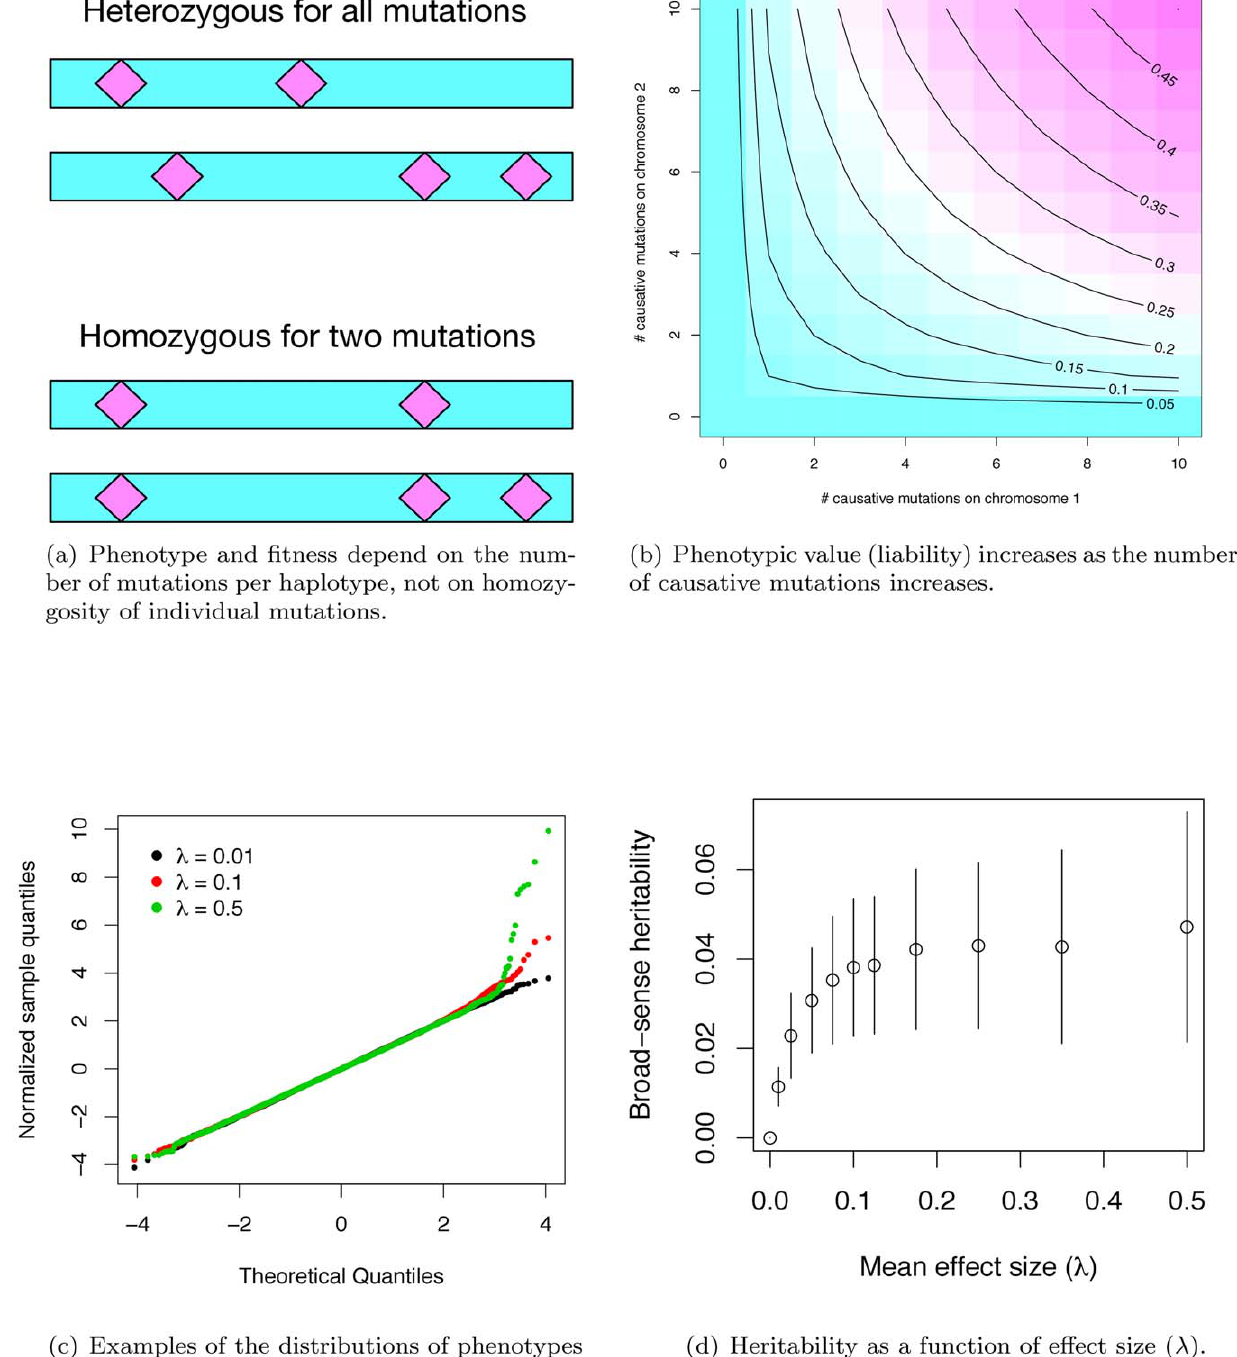
Figure 1. Phenotypes under the gene-based model. (a) Phenotype depends only on the number of causative mutations present on each haplotype, and not on whether an individual is homo- or heterozygous for particular mutations. Thus, the two diploids shown are equivalent in their expected phenotype, as both diploids contain one haplotype with two causative mutations, and a second haplotype with three such mutations. (b) Phenotype is calculated as the geometric mean of the effects of each haplotype, and is therefore determined primarily by the haplotype closest to wild-type. The panel shows the expected phenotype for diploids with different combinations of mutations on each haplotype, assuming a constant effect size of 0.05 per mutation. (c) Quantile-quantile plots of phenotypes resulting from the simulation. The x-axis is the quantiles of a unit Gaussian, and the y-axis is the z-score normalized quantiles observed in a simulated population. For three different parameter values, the phenotypes of 20,000 diploids from a single simulated population are shown. At moderate average effect sizes ( l ) (0.10 in the panel), there tends to be an excess of individuals with modestly-large phenotypes, whereas with large l , a population typically contains proportionally more individuals with large phenotypic values. (d). Broad-sense heritability as a function of l , the mean effect size of a causative disease mutation. Plotted are the mean values 6 1 standard deviation, calculated from the simulation output.